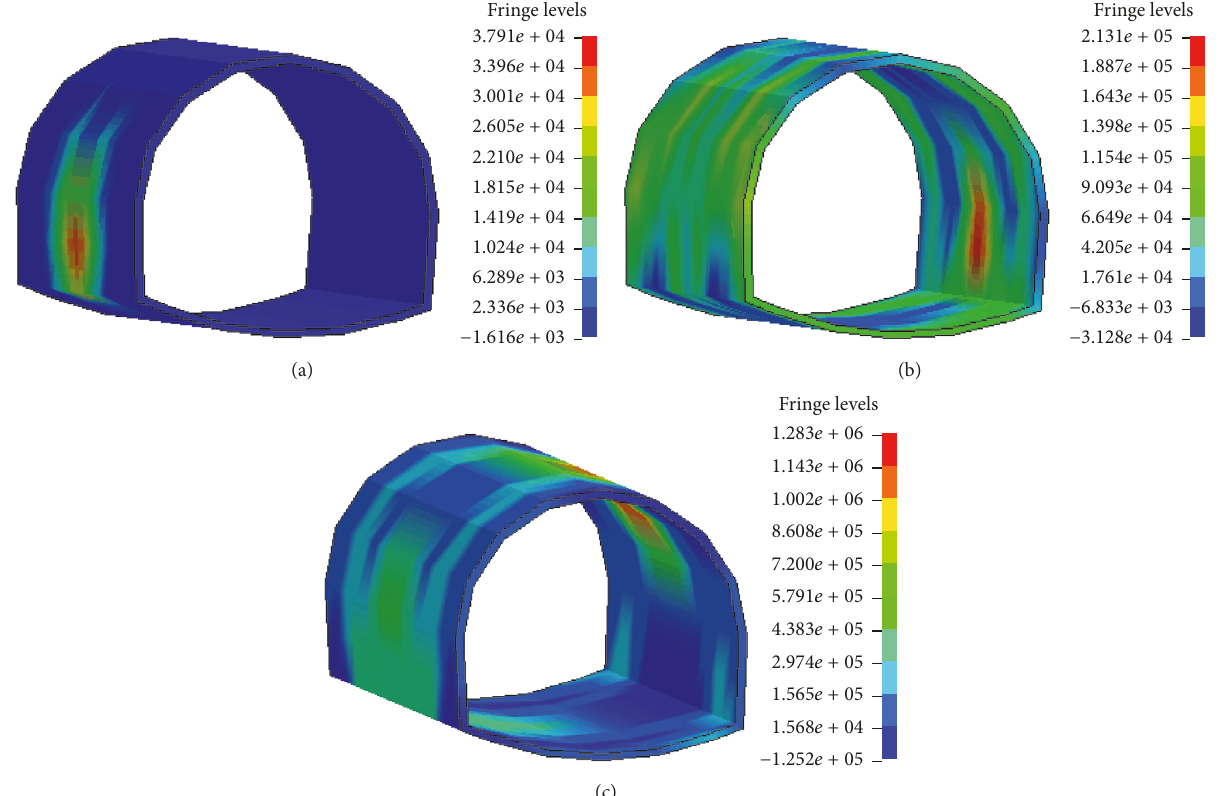
Figure 13: Maximum principle stress distribution variation induced by full-face blasting 37 m away. ( Note . Positive value for tensile stress. (a) Time = 47.5 ms, (b) time = 91.5 ms, and (c) time = 156.5 ms.)